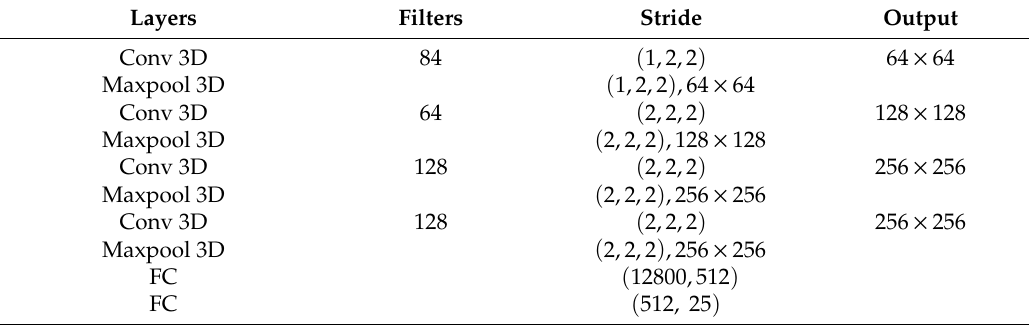
Table 2. The model parameters of the proposed 3D Convolution Neural Network (CNN)